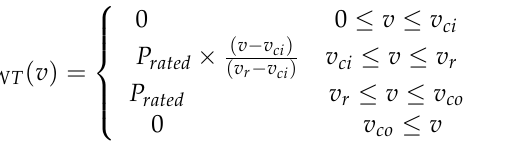
Figure 4. Modeling the distribution line with the presence of RDG sources. 3. Multi-Dimension Framework for Operating Requirements of EDN 3.1. Multi-Objective Functions The proposed multi-objective functions (MOF) for this work are devoted to searching the optimal location and size of multiple DGs based on the PV and WT units in both test systems’ EDNs, to simultaneously minimize the target indices: APLI, RPLI, VDI, OTI, and CTII. The next equation represents its formulation: 𝑀𝑂𝐹 = 𝑀𝑖𝑛𝑖𝑚𝑖𝑧𝑒 (cid:3533) (cid:3533) (cid:3533) (cid:3533) (cid:3533)[𝐴𝑃𝐿𝐼 (cid:3036),(cid:3037) + 𝑅𝑃𝐿𝐼 (cid:3036),(cid:3037) + 𝑉𝐷𝐼 (cid:3037) + 𝑂𝑇𝐼 (cid:3036) +𝐶𝑇𝐼𝐼 (cid:3036),(cid:3037)(cid:3015) (cid:3251)(cid:3267) (cid:3037)(cid:2880)(cid:2869)(cid:3015) (cid:3265)(cid:3267) (cid:3036)(cid:2880)(cid:2869)(cid:3015) (cid:3277)(cid:3296)(cid:3294) (cid:3037)(cid:2880)(cid:2870)(cid:3015) (cid:3277)(cid:3296)(cid:3294) (cid:3037)(cid:2880)(cid:2870)(cid:3015) (cid:3277)(cid:3296)(cid:3294) (cid:3036)(cid:2880)(cid:2869)